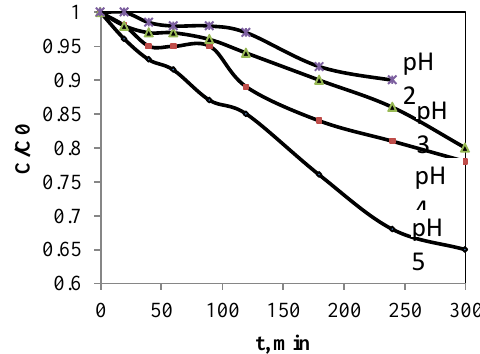
Fig.2. Time variation of Cu(II) adsorption on PSTM- 3T at different pHs.